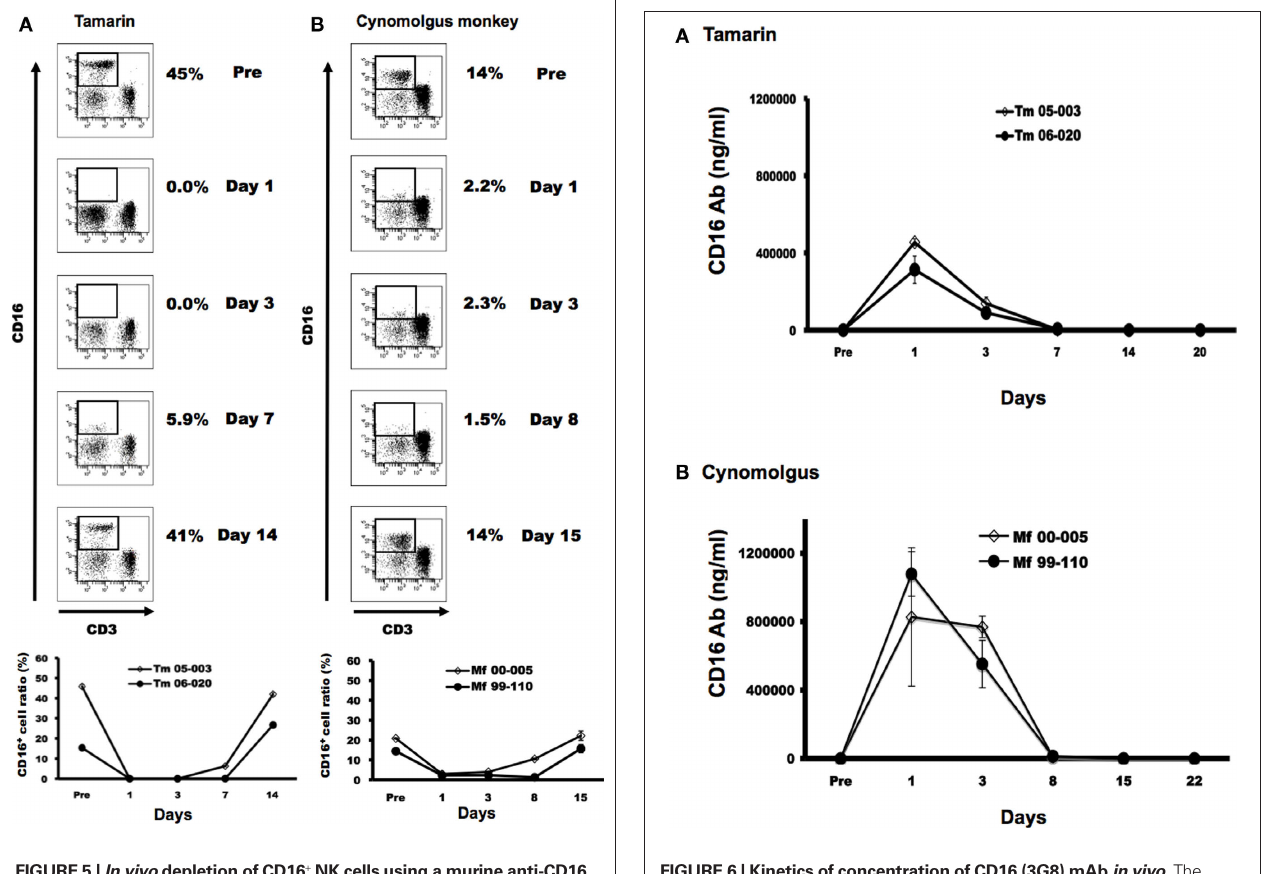
Figure 5 | In vivo depletion of CD16 + NK cells using a murine anti-CD16 (3g8) mAb in tamarins. (A,B) Tamarins and cynomolgus monkeys were administered with 50 mg/kg of the 3G8 mAb. CD16 + NK cell numbers were determined in whole blood specimens. Tamarins: Tm 05-003 and Tm 06-020. Cynomolgus monkeys: Mf 00-005 and Mf 99-110.